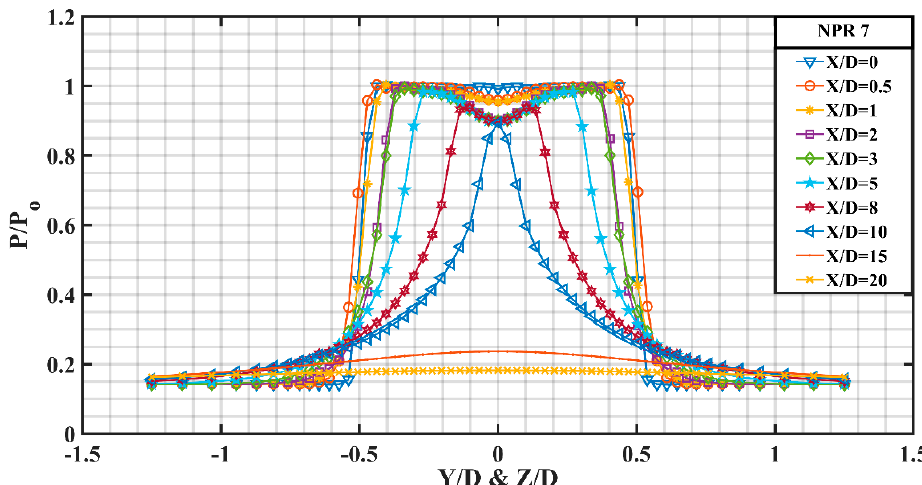
Figure 22. Pressure profile variation for uncontrolled jet at NPR 7.